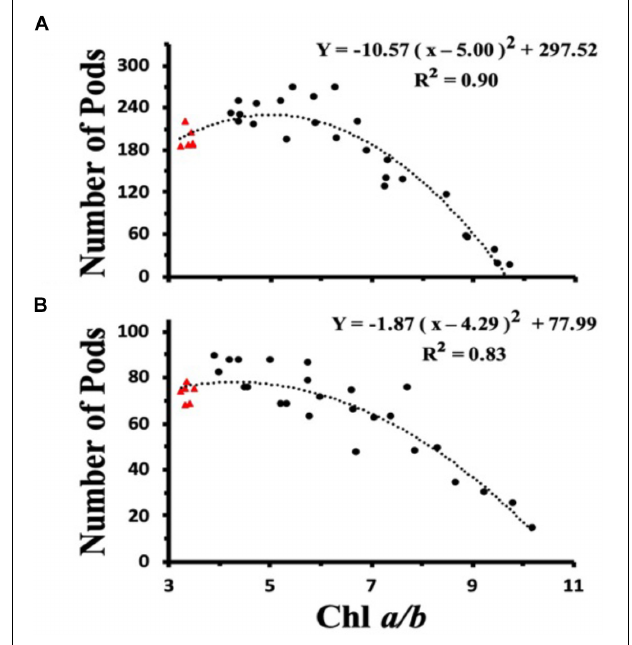
FIGURE 7 | Chl a/b ratio dependent changes in seed pod number in wild-type (triangles) and CAO RNAi transgenic lines (circles) grown in moderate light (ML) (850 µ mol photons m − 2 s − 1 ) (A) or in low light (LL) (200 µ mol photons m − 2 s − 1 ) (B) . The data were fit with a second order polynomial function. Chl content was determined according to Porra et al. (1989).